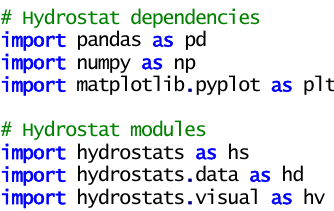
Figure 1. Example code showing loading of the hydrostats package, modules, and other dependencies.